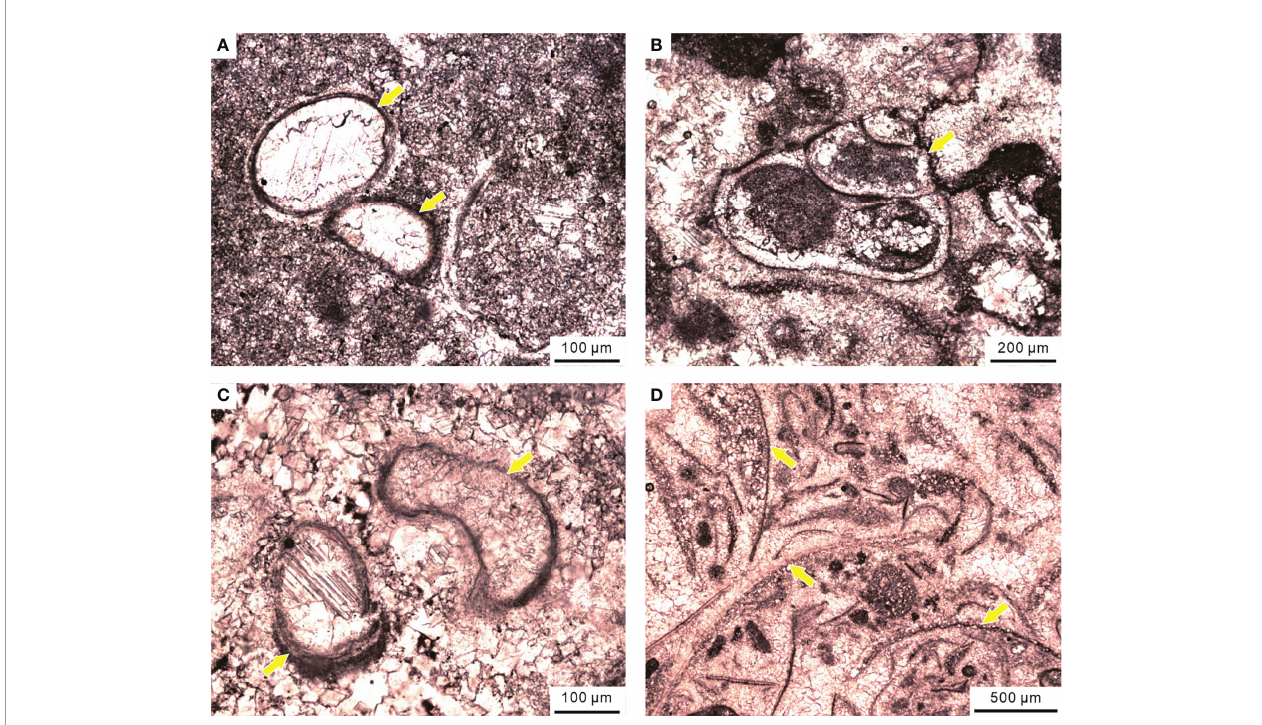
FIGURE 14 | Disaster forms in the MU of the Chongyang section during the PTME, including (A) ostracods, (B) small gastropods, (C) calcareous tubeworms, and (D)